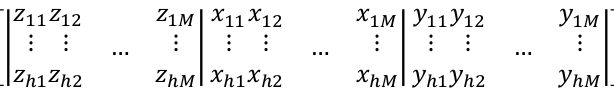
Fig. 3. Detailed view of the chromosome